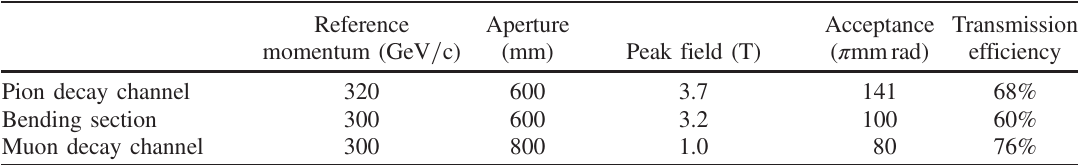
density.FIG. decay channel. FIG. 13. Distributions of the pion/muon beam in the transverse phase planes at the end of the pion decay channel. The scale “ Counts ” used on the right is for relative comparison on TABLE III. Transverse acceptances of the pion = muon transport